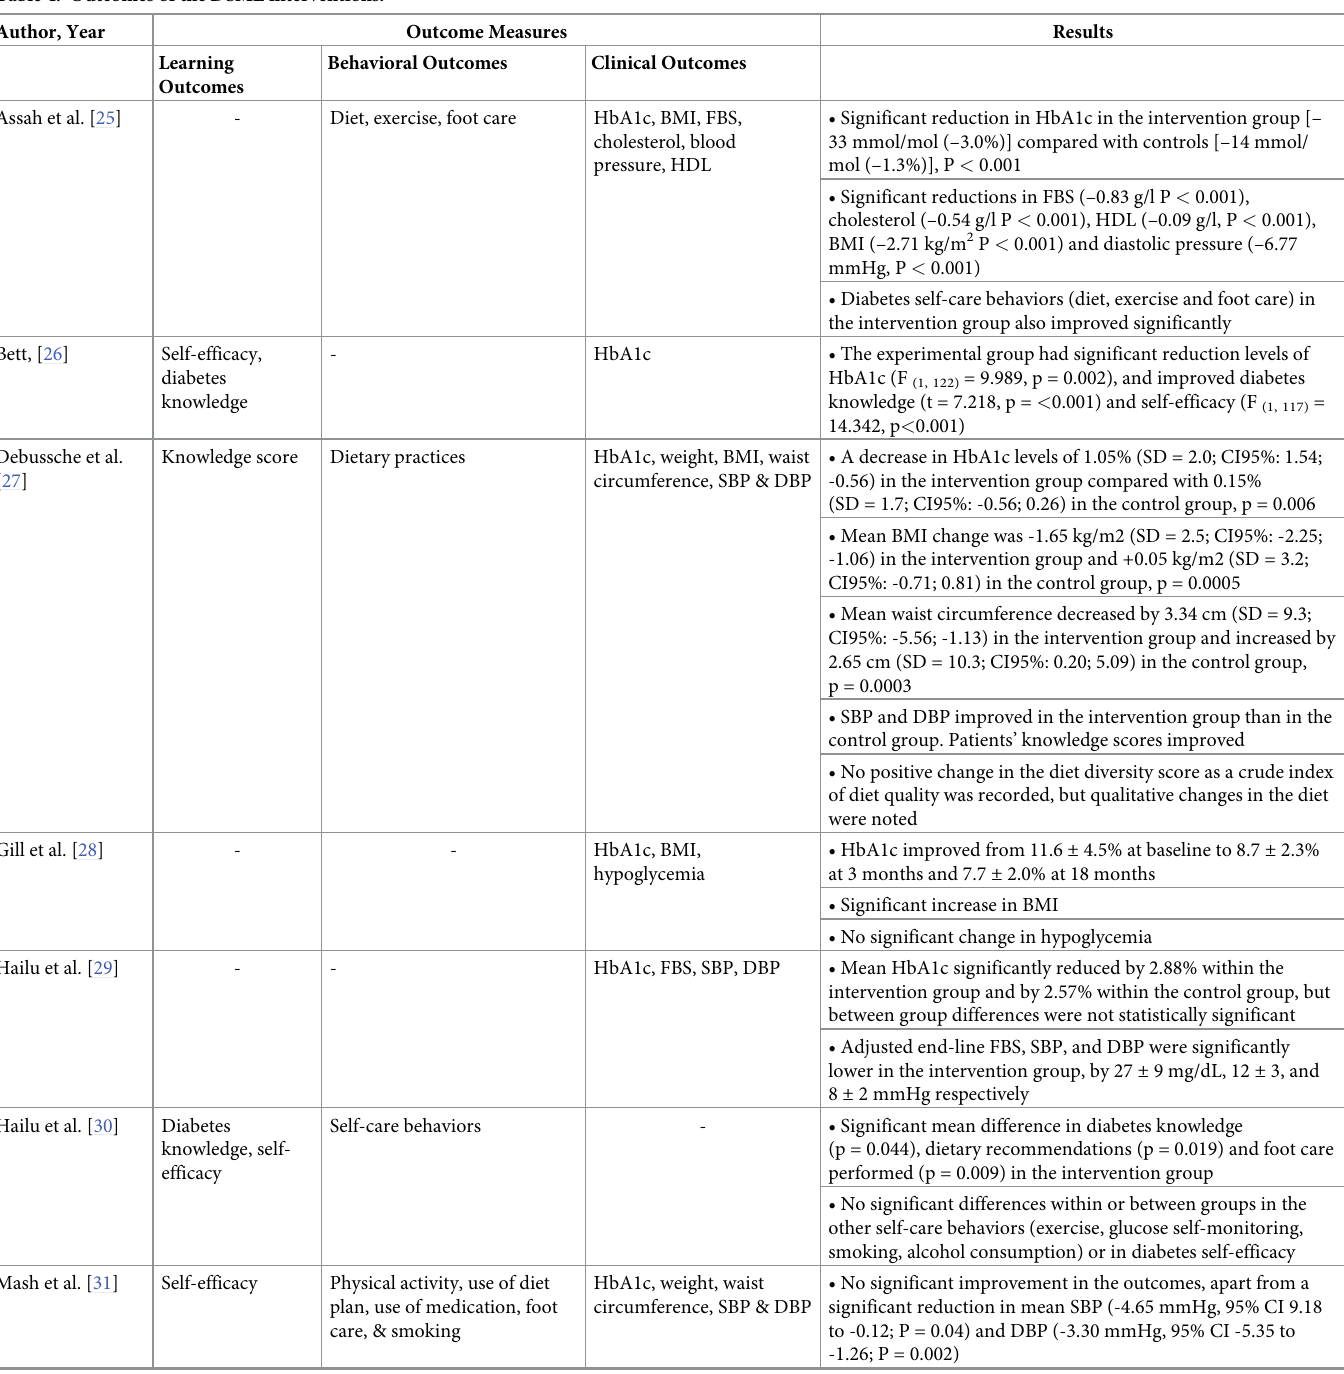
Table 4. Outcomes of the DSME